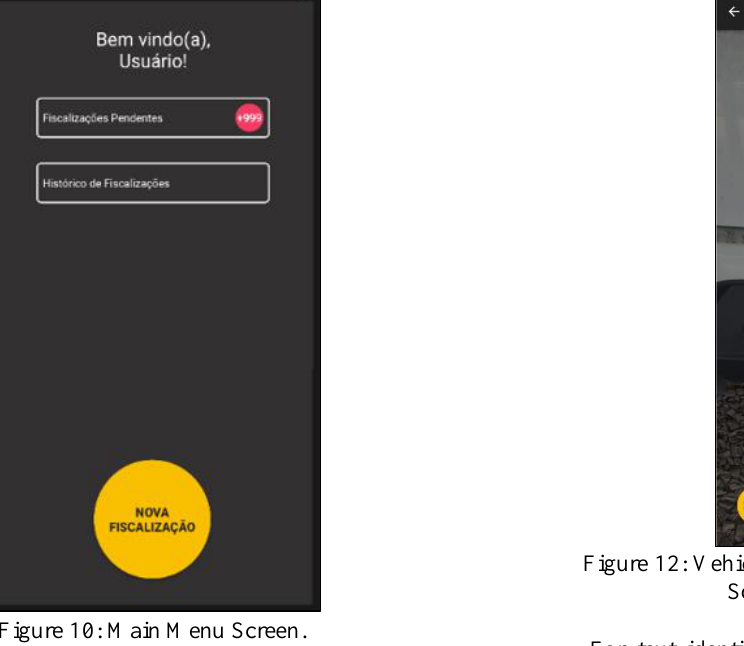
Figure 10: Main Menu Screen.